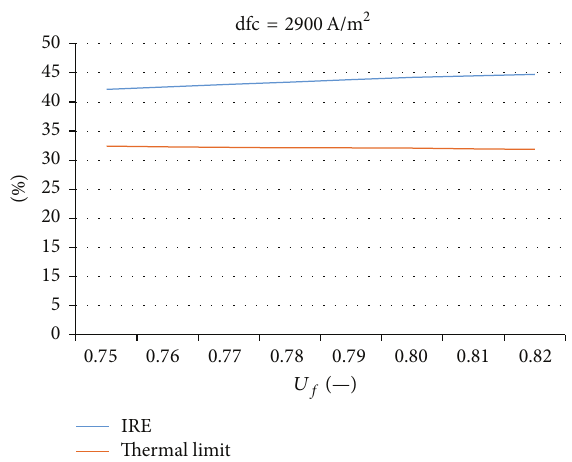
Figure 10: IRE (blue) and LT (red) at varying 𝑈 𝑓 .